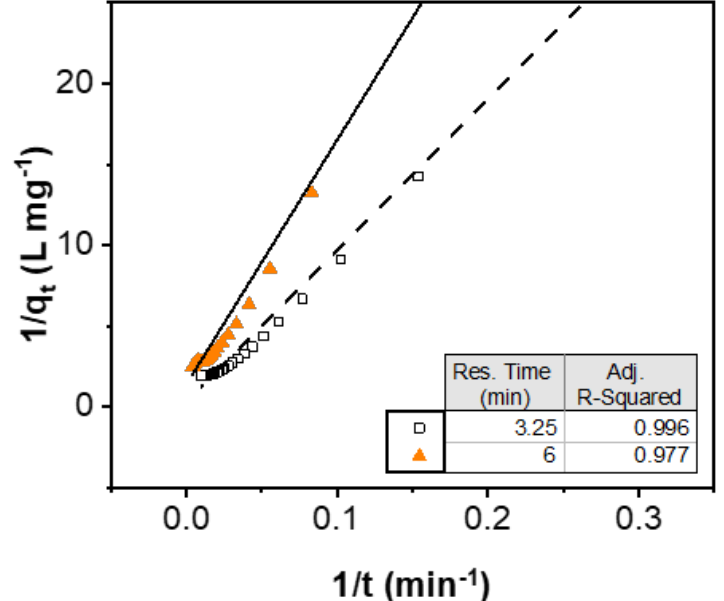
Figure 7. Linear regression fit of data to second order kinetics equation in agreement with expected pseudo-second order behavior.